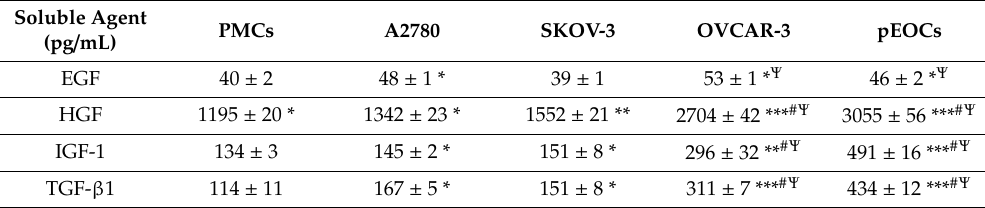
Table 1. Concentration of the proteins known to induce epithelial-mesenchymal transition (EMT) in the conditioned medium harvested from PMCs and ovarian cancer cells.